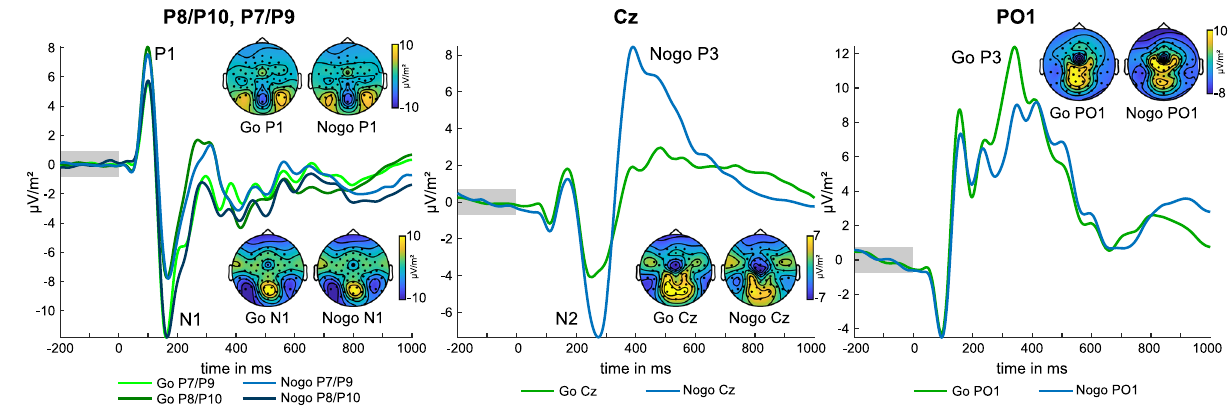
Fig. 1 Event-related potentials (ERP) for Go and Nogo trials. P1 and N1 ERPs are depicted at electrodes P7/P9 and P8/P10. N2 ERP is depicted at electrode Cz, P3 ERP at electrode Cz, and PO1. Go trial EEG data are depicted in green color, Nogo data in blue color. Additionally, scalp topography plots show voltage distribution at the time point of the respective ERP peak. Timepoint zero denotes the time point of